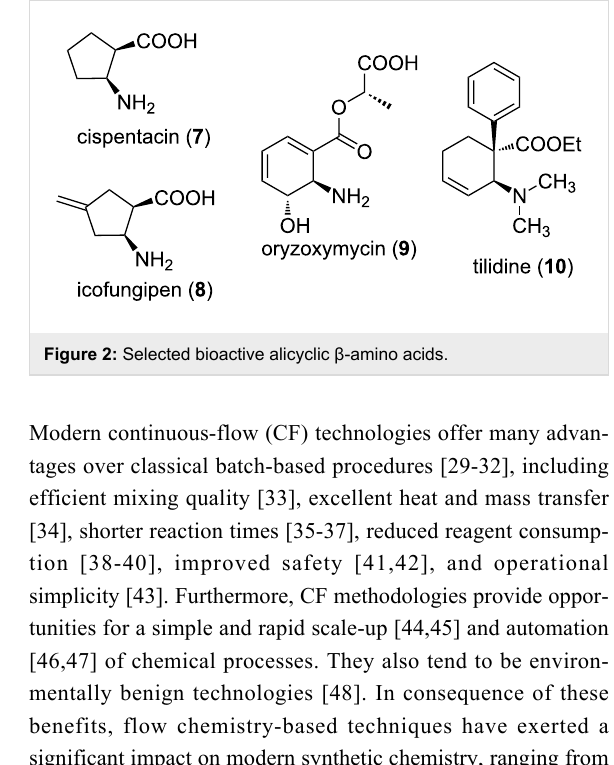
Figure 1: Examples of 1,2,3-triazoles with various biological activities.